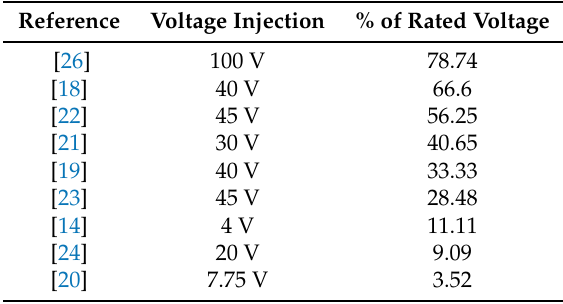
Table 1. Different injection levels found in the